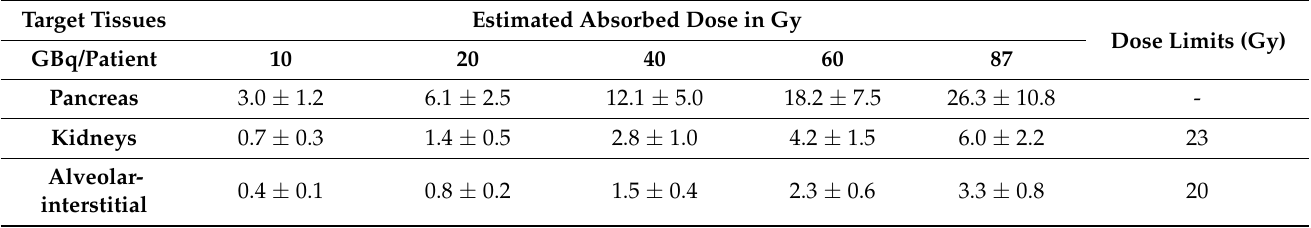
Table 4. Estimated absorbed doses (Gy) at various administered activities of [ 67 Cu]Cu-SAR-BBN, shown as mean ± standard deviation. Dose limits